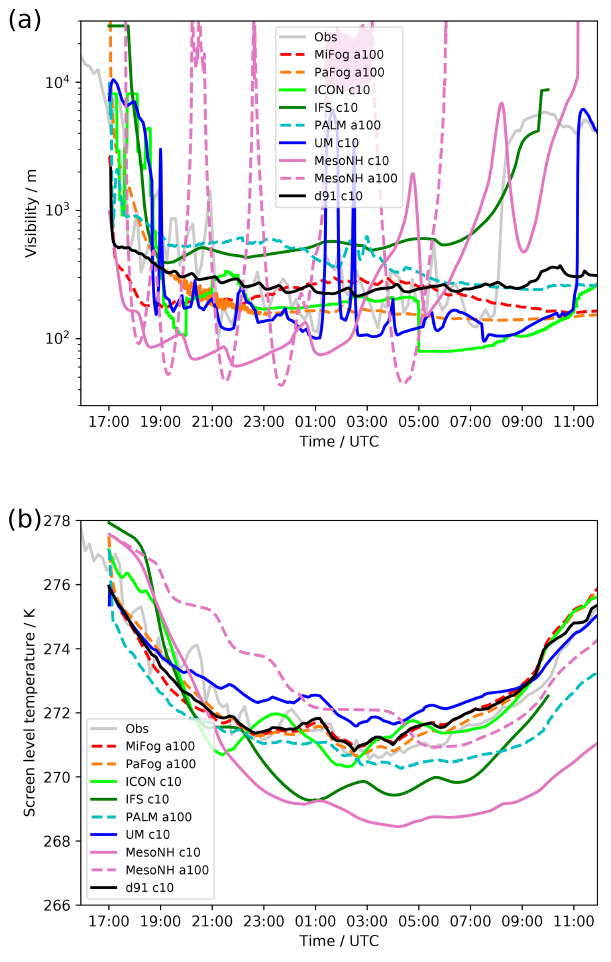
Figure 10. (a) Visibility and (b) screen level temperature, observed and predicted by all models including a specific visibility parame- terisation.